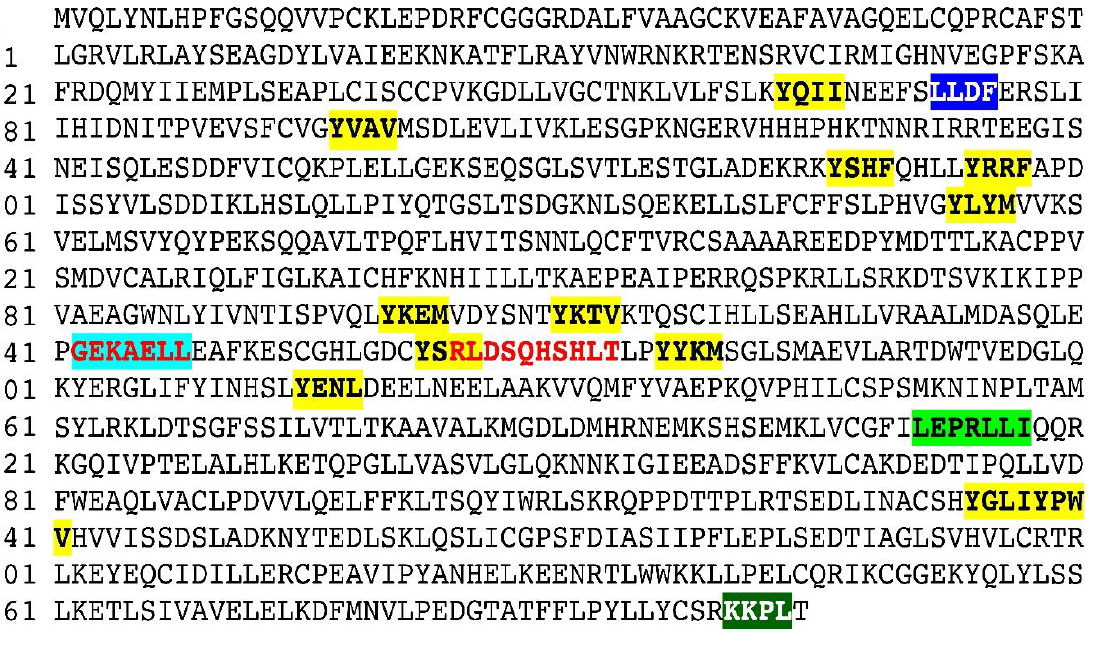
Figure 4. HPS3 protein contains clathrin-binding motif LLDF (aa 172 – 174), endoplasmic reticulum membrane retention signal KKPL (at 1000 – 1003), 2 dileucine-based sorting motifs GRKAELL (aa 542 – 548) and LEPRALLI (aa 711 – 717), 12 Tyrosine Sorting motifs, and 1 peroxisomal matrix targeting signal RLDSQHSHLT (564 – 573).